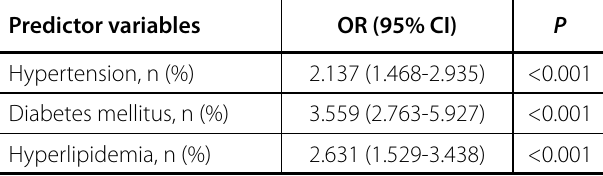
Table 4. Multivariate analysis of predictors of high SYNTAX score.